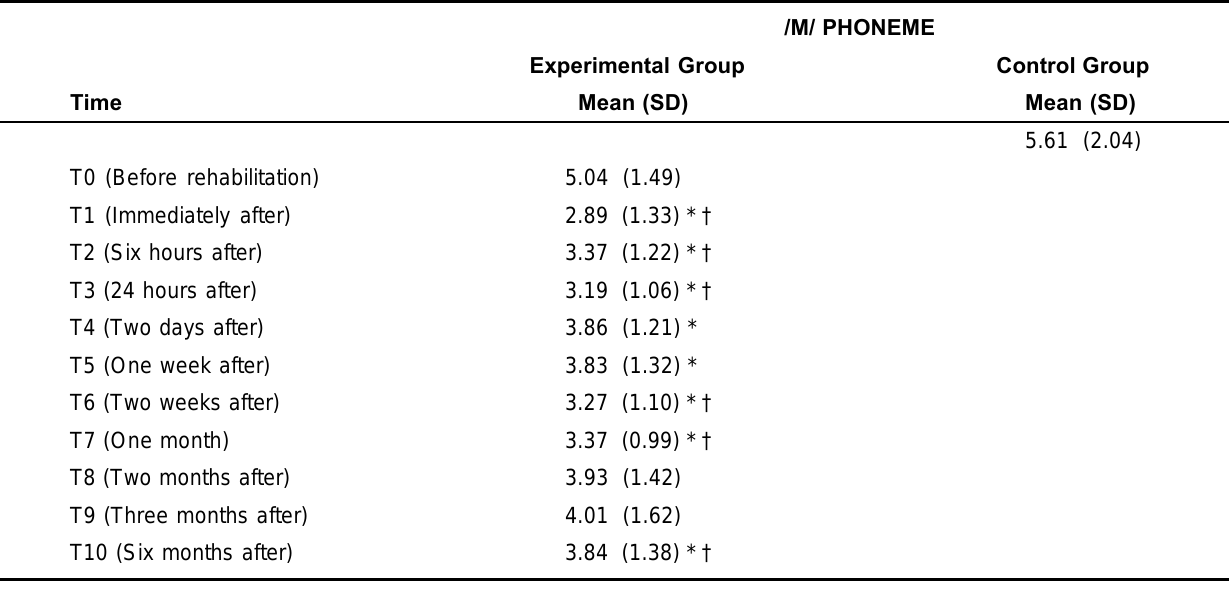
TABLE 2- Means and Standard Deviations of Interocclusal Distance (mm) During /s/ Sound Pronunciation, Before and After New Prosthesis